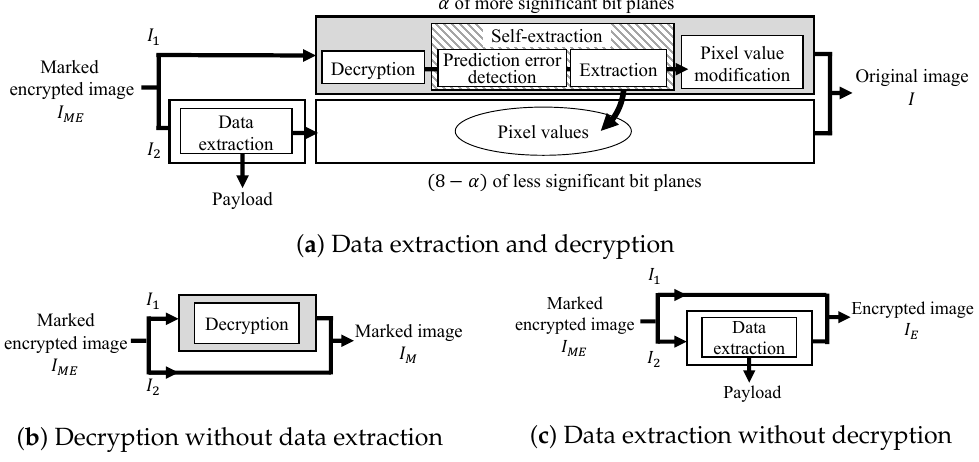
Figure 6. Restoration process of the proposed